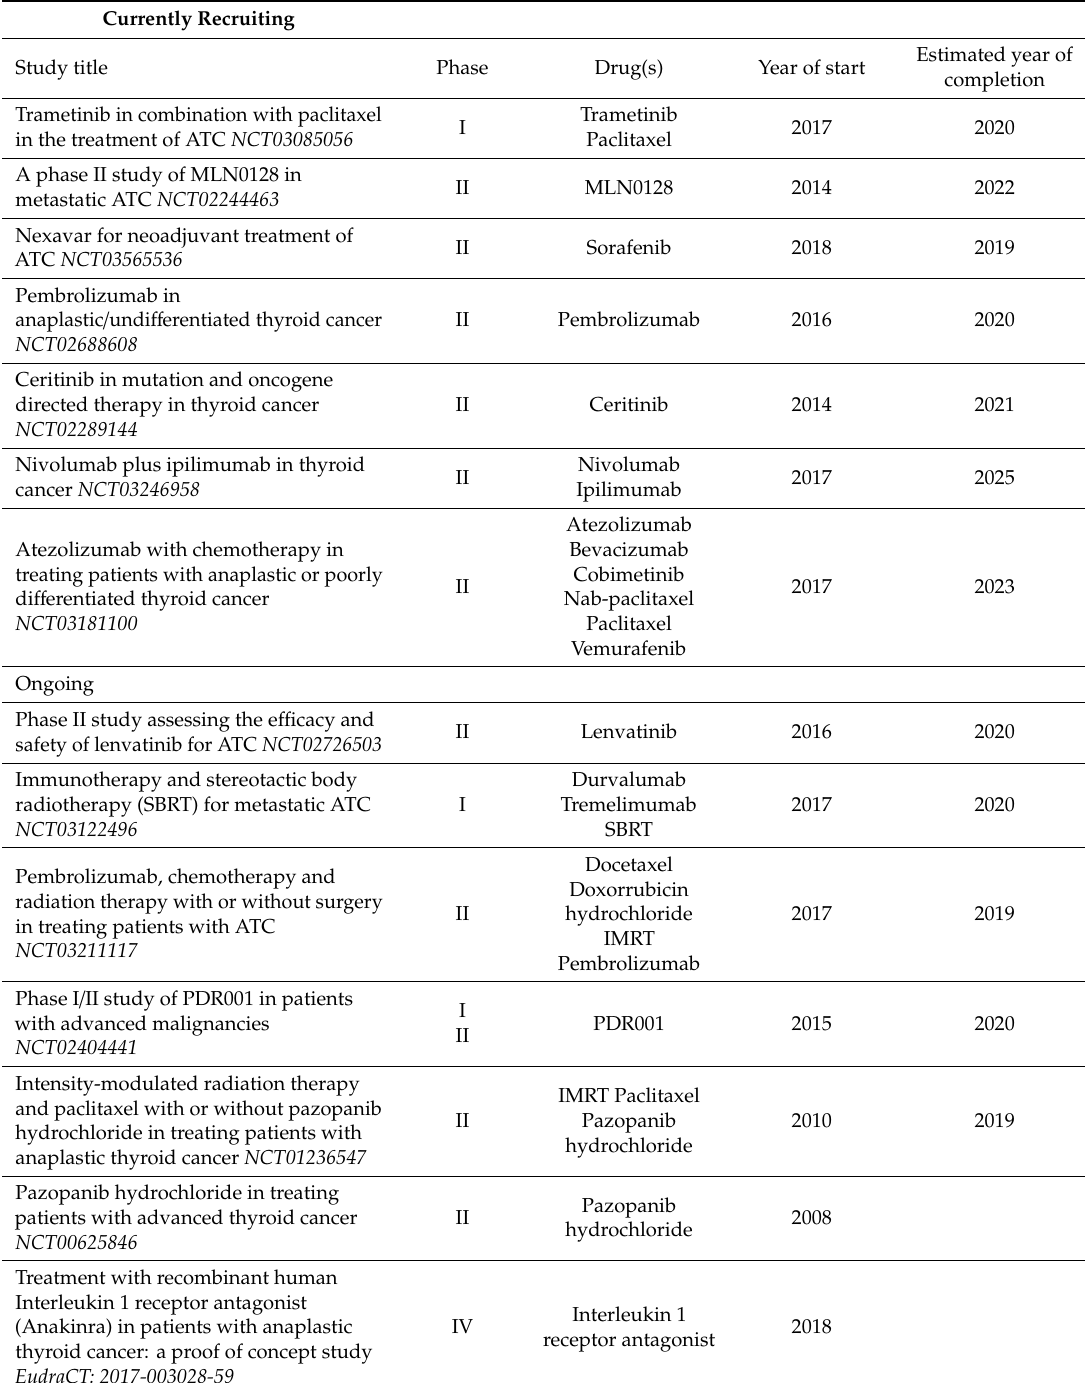
Table 5. Currently recruiting and ongoing clinical trials of tyrosine kinase and immune checkpoint inhibitors in